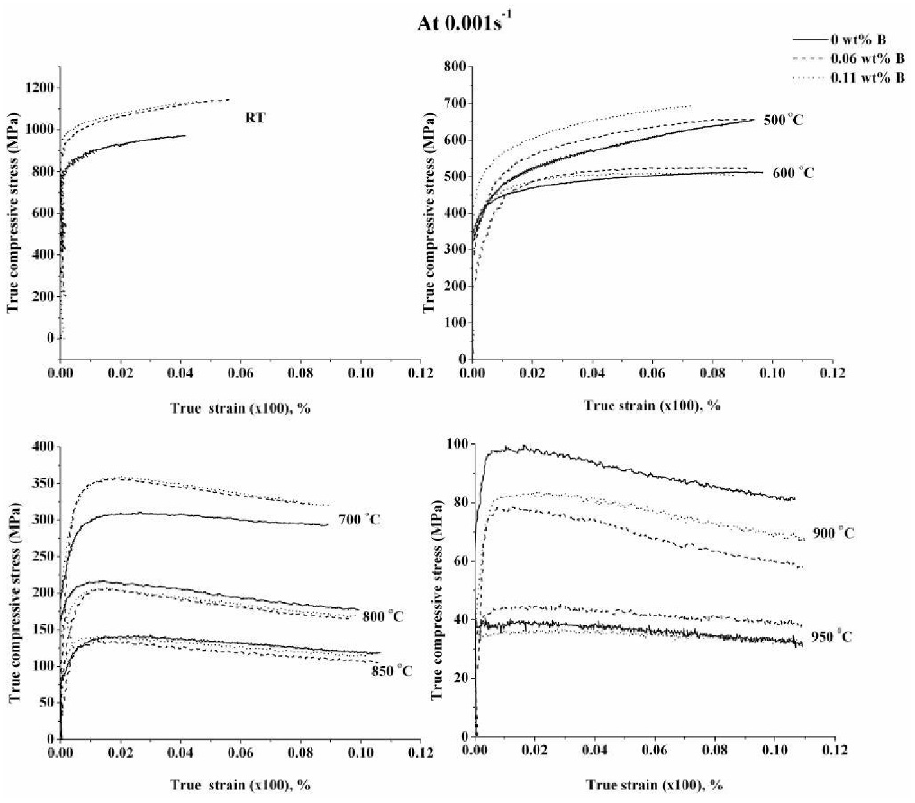
Figure 6. True stress-strain curves for Ti-64 and the two variants with B, tested at different temperatures and with a strain rate of 0.001 s − 1